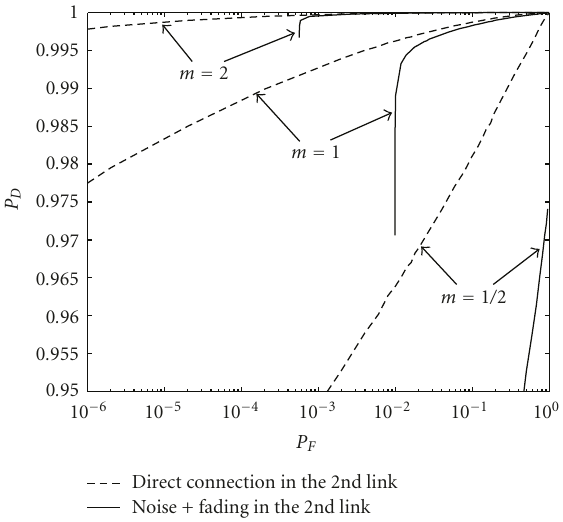
Figure 3: P D versus P F for K = 2, for di ff erent Nakagami fading, γ = 20